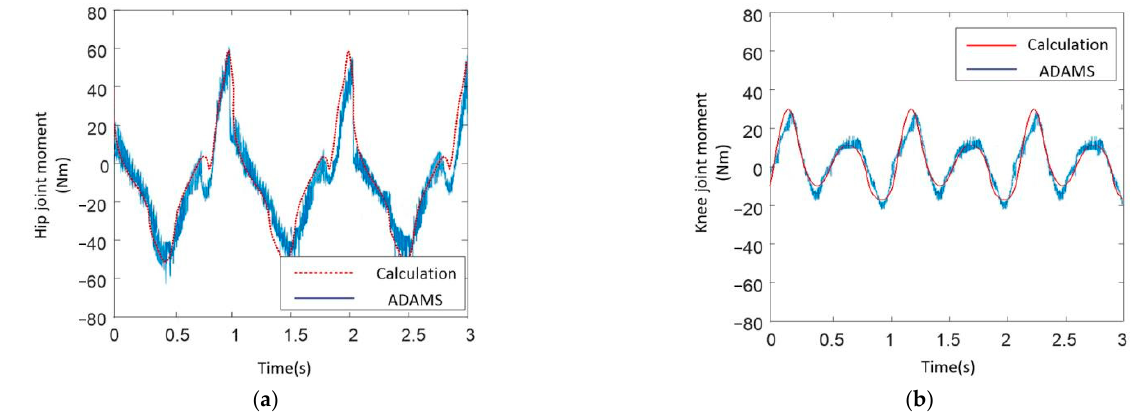
Figure 23. Simulation curves of exoskeleton. ( a ) hip joint moment curve; ( b ) knee joint moment curve.